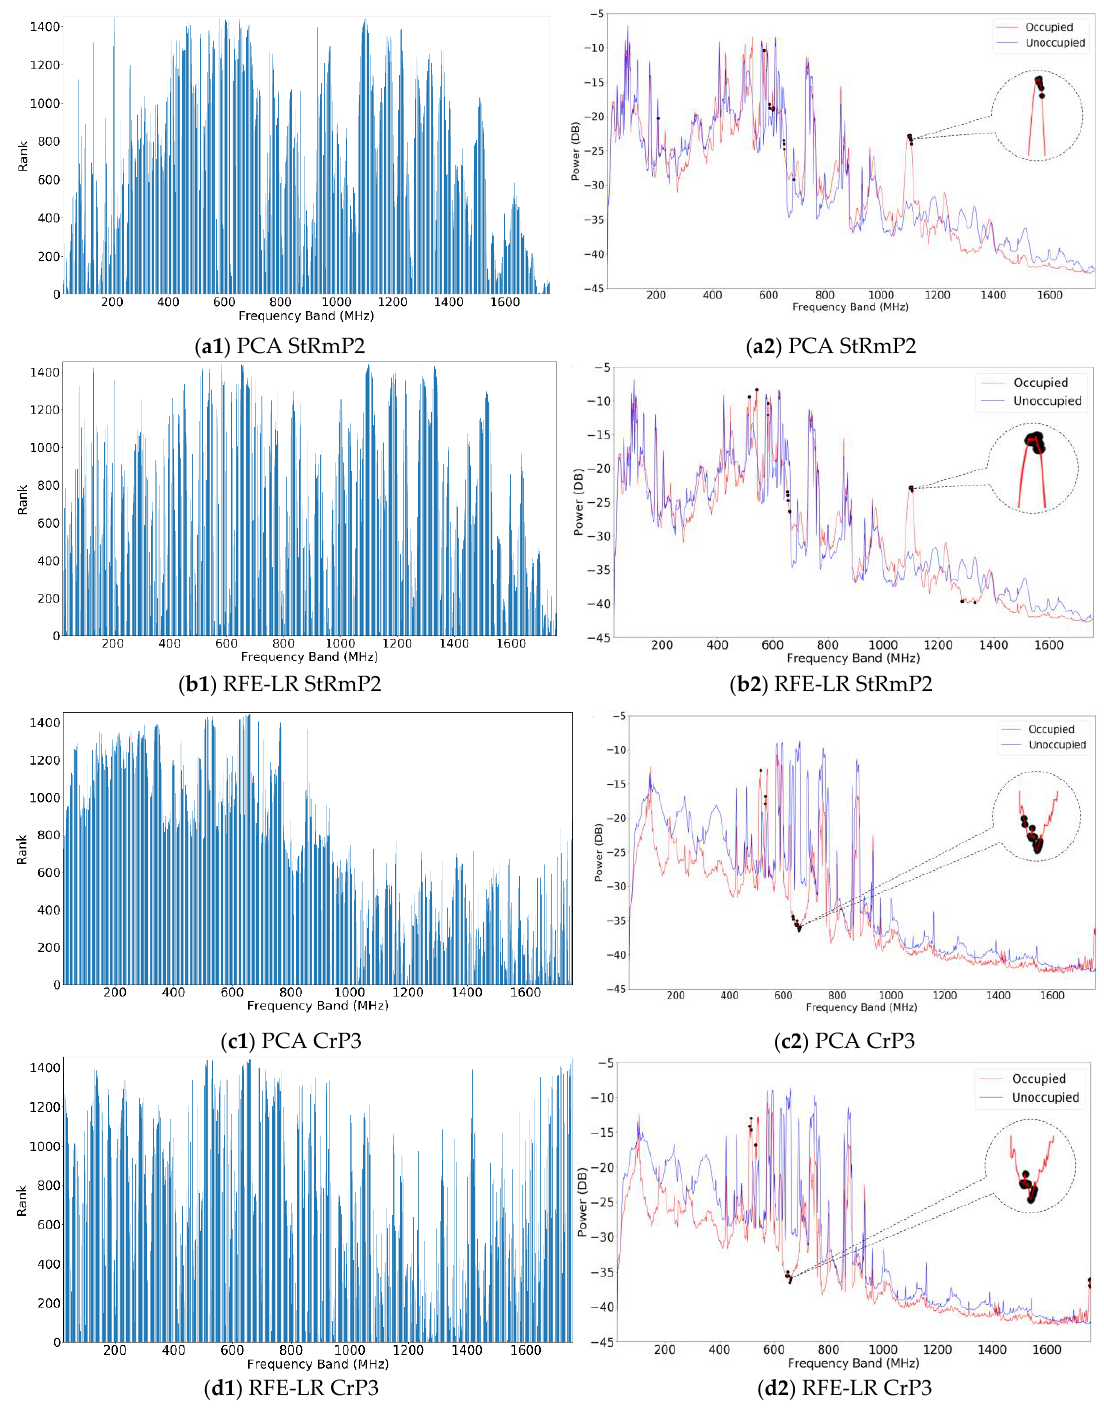
Figure 4. Examples of the dynamic band ranking and selection results from the PCA and RFE-LR. The two scenarios are StRmP2 and CrP3. The subfigures in the left column display the rank of each frequency calculated by the PCA and RFE-LR-based band selection algorithms, while the subfigures in